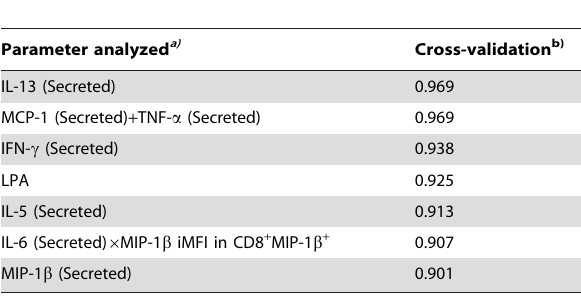
Table 1. Correlates of immunity against F. tularensis as suggested by the accuracy of prediction